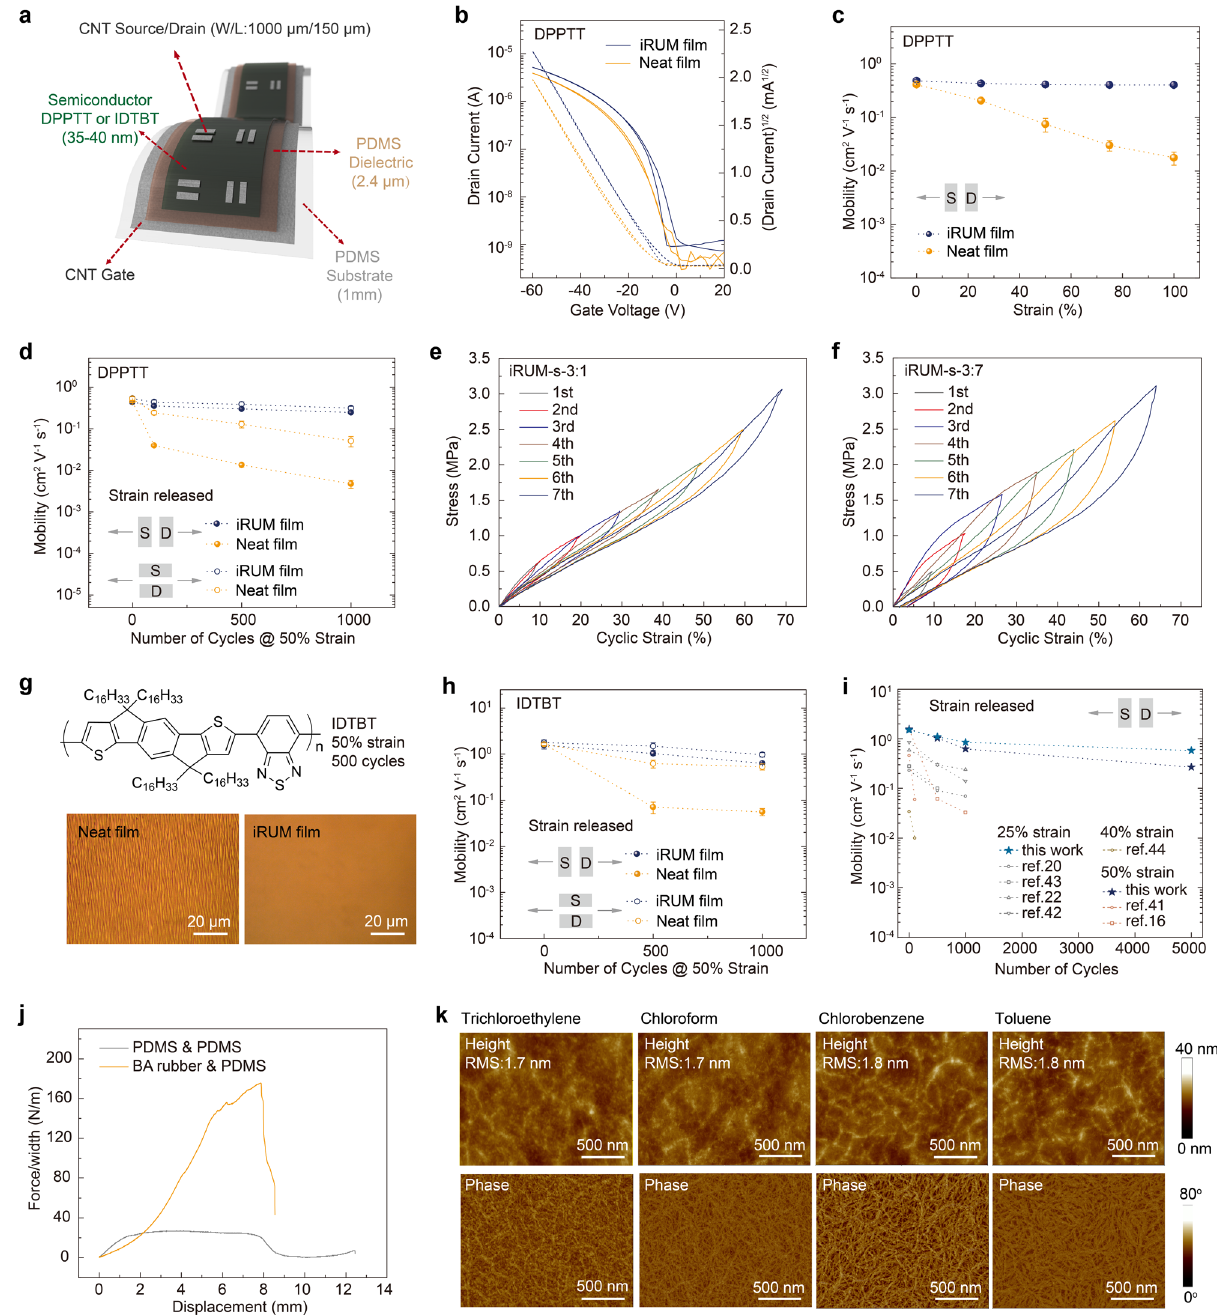
Fig. 3 Characterization of the electrical performance of iRUM-s under mechanical deformation and solvent treatment. a Device structure of a fully stretchable transistor with a bottom-gate top-contact con fi guration, W/L = 1000 μ m/150 μ m. b Representative transfer curves of a stretchable transistor with neat DPPTT fi lm or iRUM-s as the semiconductor. c Evolution in mobility at different strains during single stretching, with charge transport parallel to stretching direction. d Evolution in mobility after multiple stretching-releasing cycles at 50% strain under strain released state, with charge transport parallel and perpendicular to stretching direction. Stress-strain (engineering) curves with a cyclic strain range of 10 – 70% for iRUM-s-3:1 ( e ) and iRUM-s- 3:7 ( f ) fi lms, where an iRUM-s fi lm (35 nm thick) was supported on a thin PDMS substrate (2.4 μ m thick). g Optical microscope images of IDTBT and iRUM-IDTBT after 500 stretching-releasing cycles at 50% strain under strain released state. h Changes in mobility of a neat IDTBT fi lm and an iRUM- IDTBT fi lm after multiple stretching-releasing cycles at 50% strain under strain released state. i Comparison of the cyclic durability in this study with previously reported results in the literature 16,20,22,41 – 44 (spin-coated semiconductor fi lms using insulating polymer dielectrics under strain released state without applying other engineering techniques, which re fl ects the intrinsic properties of semiconductors). j Curves of the peeling force per width of PDMS sheet versus displacement for BA rubber and PDMS. The higher peeling force between BA rubber and PDMS indicates the formation of interfacial crosslinking. k AFM height and phase images of iRUM-s-3:1 after soaking in various organic solvents (trichloroethylene, chloroform, chlorobenzene, and toluene) for 30 s. The surface roughness is extracted from the AFM height image.